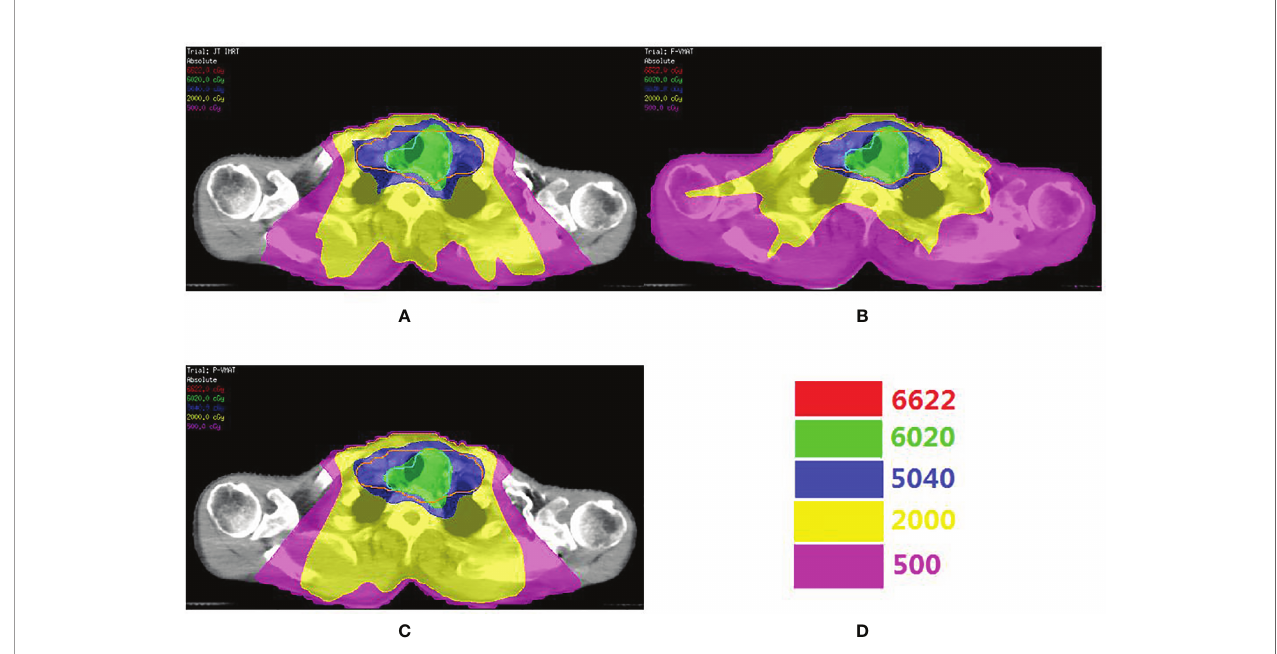
FIGURE 1 | The comparison o dose distribution in JT IMRT (A) , F-VMAT (B) and P-VMAT (C) for one patient. The green outline is PGTV. The orange outlineis PCTV. (D) Shows the isodose line.